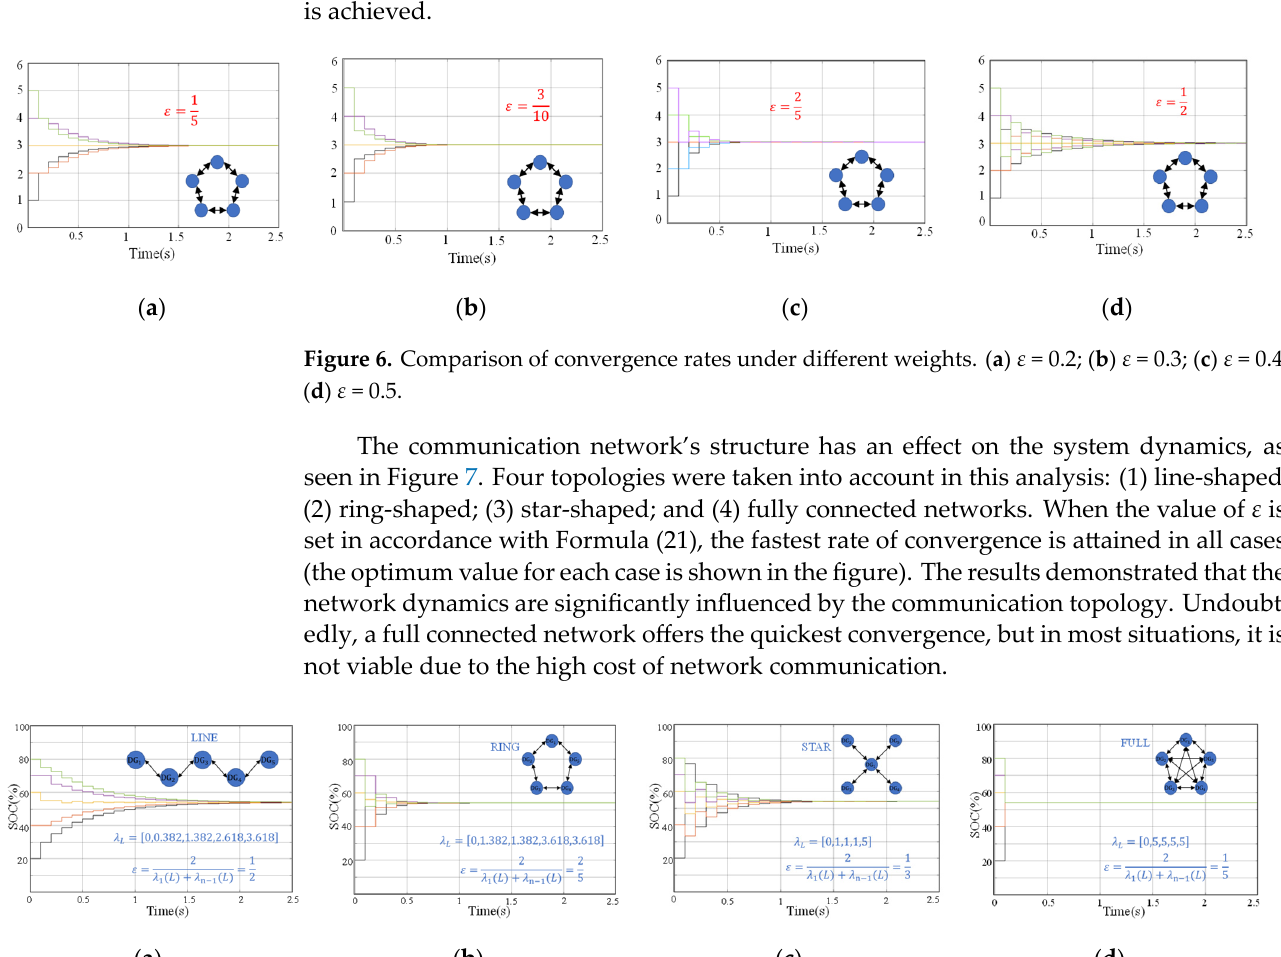
Table 1. Circuit and control parameters.